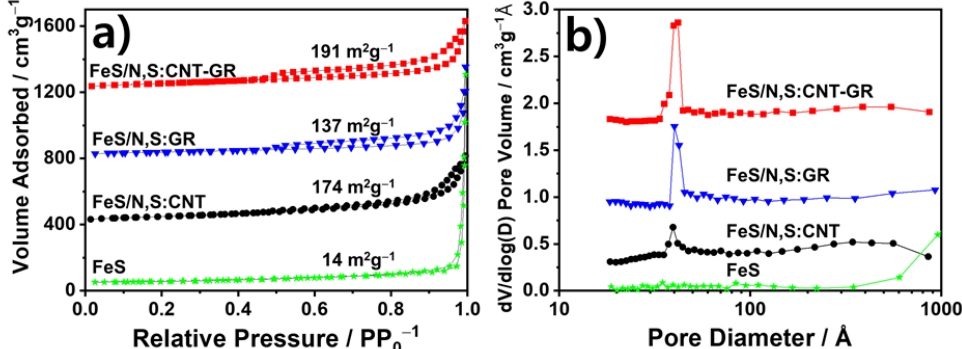
Figure 3. ( a ) N 2 -sorption isotherm and ( b ) Pore size distribution of prepared FeS